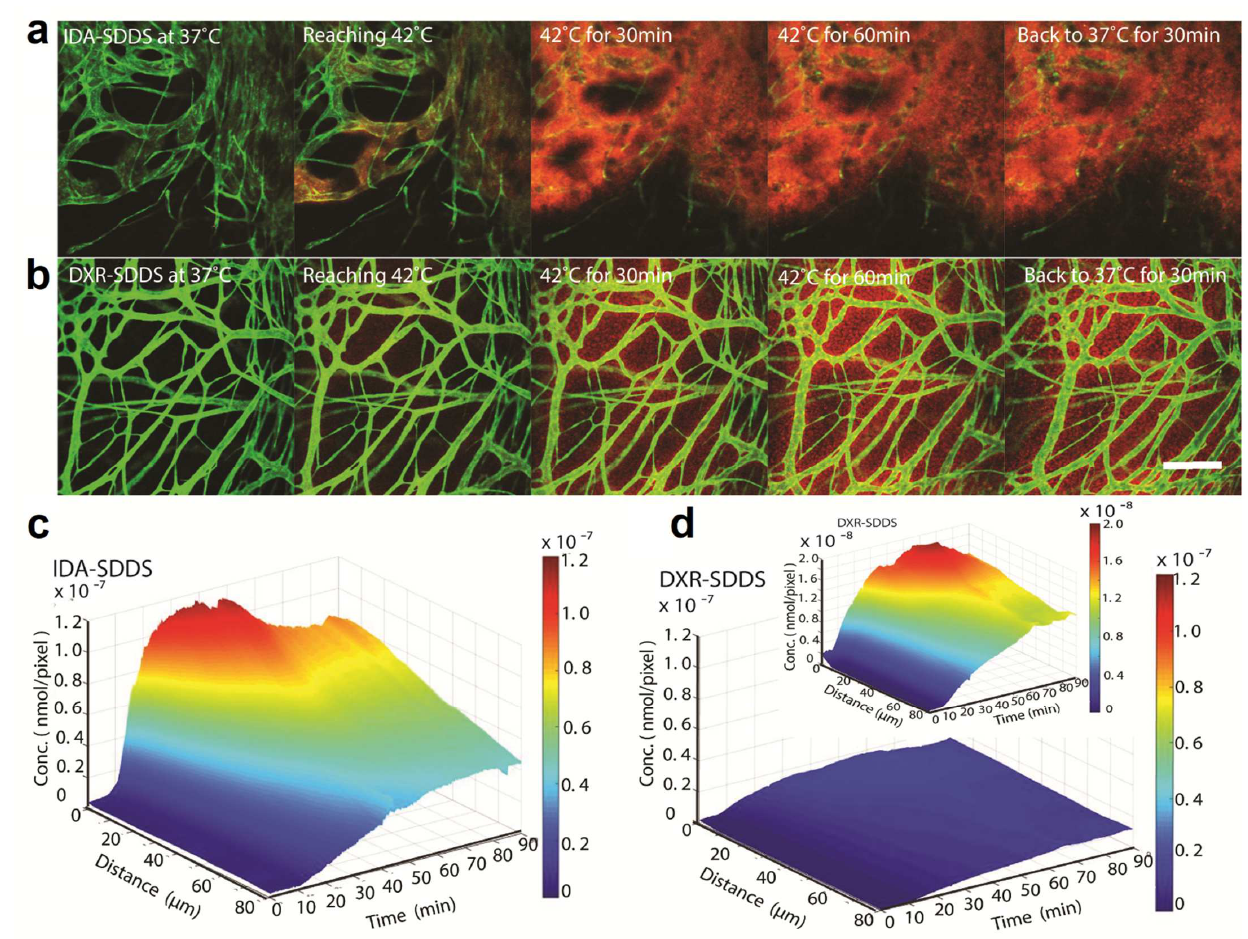
Figure 6. Rapid uptake of idarubicin (IDA) upon fast heat-triggered release from TSL results in a higher local drug delivery and a sharper intratumoral gradient compared to doxorubicin (DXR). ( a , b ) Imaging of the heat-triggered release in a window chamber fixed on eNOS-Tag-GFP mice with green vessels. Eighteen µ mol/kg of IDA-SDDS ( a ) or DXR-SDDS ( b ) was injected, followed by 1 h local hyperthermia and 30 min normothermia, showing the intravascular drug (red) release and the subsequent diffusion into the tumor interstitium. Scale bar, 200 µ m. Panels c and d show the 3-D representation of intratumoral drug concentration, as a function of time and distance from the nearest vessel. The faster and higher uptake of IDA ( c ) than DXR ( d ) by the tumor is clear ( n = 3 mice per group). Reprinted from [28] under the Creative Commons